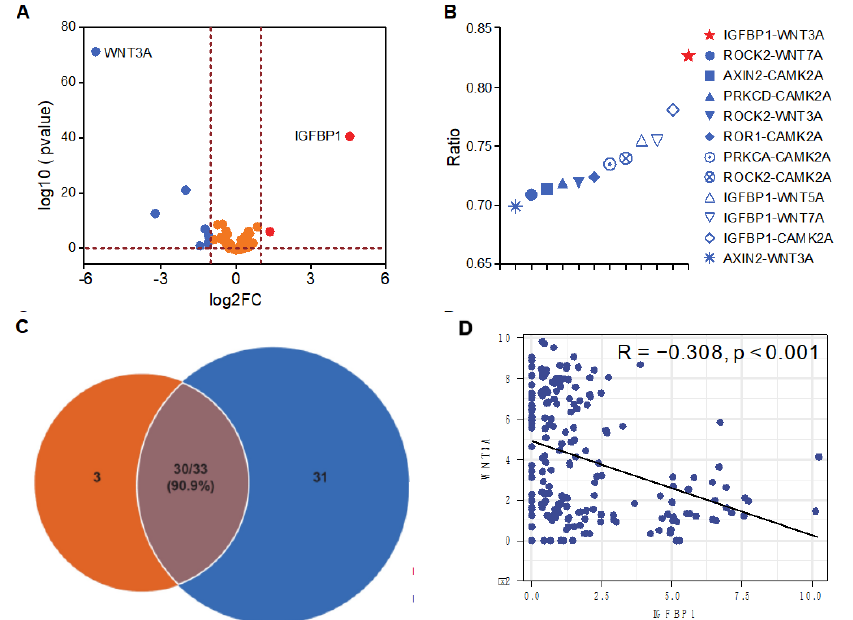
Figure 2. Potential predictors of immunotherapy efficacy. ( A ) Volcano plot showing that IGFBP1 and WNT3A were most significantly differentially expressed; ( B , C ) the consistency of the upregulated and downregulated combination subtype was compared with Clusters 1, 2 and 3; ( D ) correlation analysis of IGFBP1 and WNT3A expression.